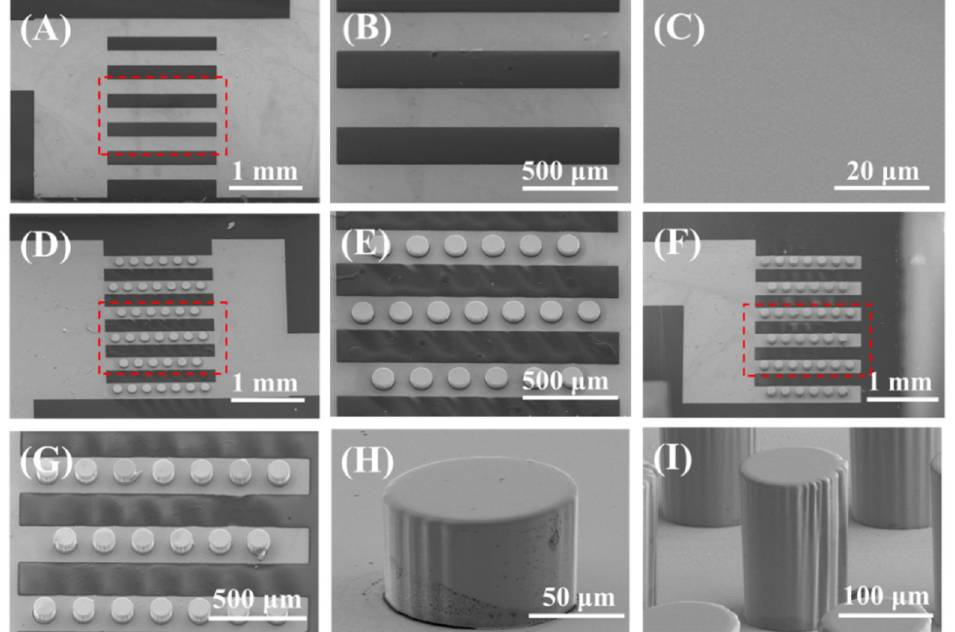
Figure 7. The SEM images of the planar electrode, the developed electrode bottom layer and the electrode top layer. ( A – C ) the top view and the enlarge view of the planar electrode. ( D , E ) the top view and the enlarge view of the bottom electrode layer with the 50 − µm micropillars. ( F , G ) the top view and the enlarge view of the top electrode layer with the 150 − µm micropillars. ( H , I ) the single micropillar with heights of 50 µm and 150 µm.